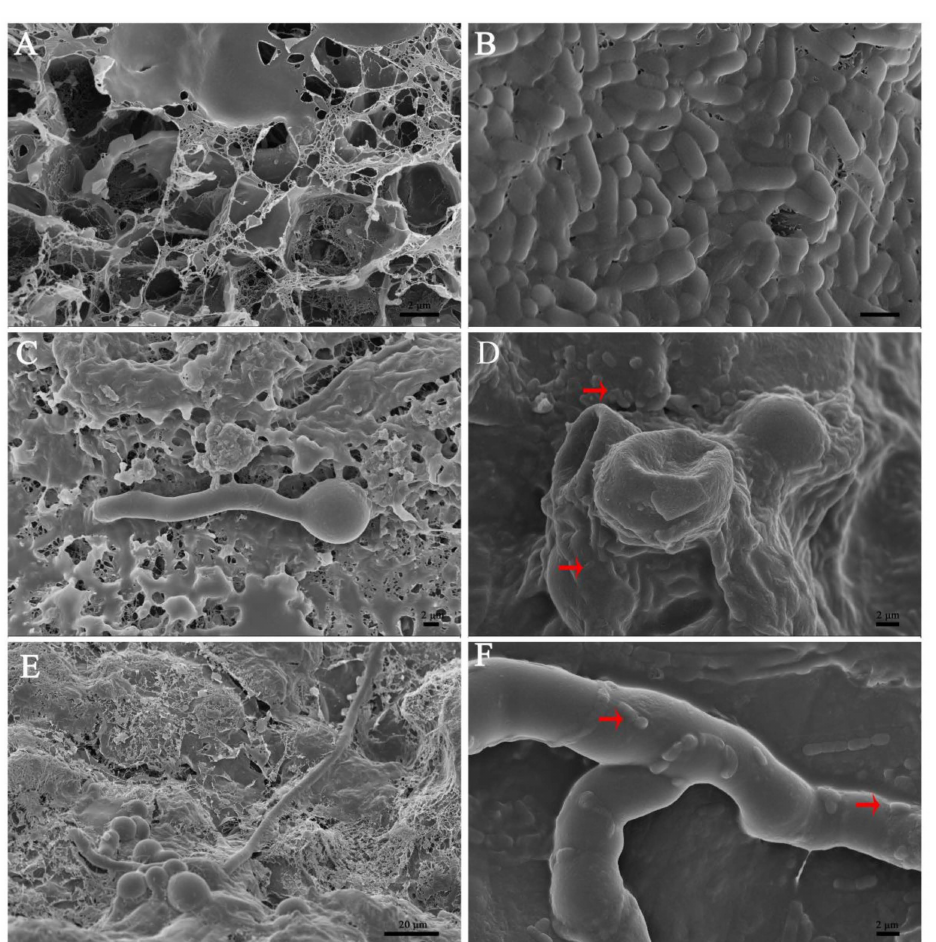
Figure 10. Scanning electron micrographs of colonization of endophyte Bacillus subtilis L1-21 on pathogens in citrus. Wound inoculation was carried out and the experiments were performed as ( A ) CK, 24h after treatment; ( B ) L1-21, 24 h after treatment; ( C ) Penicillium digitatum spore, 12 h after treatment, spores germinate normally; ( D ) P. digitatum spore + L1-21, 12 h after treatment, germinating spore deformity; ( E ) P. digitatum spores, 24 h after treatment; ( F ) P. digitatum spore + L1-21, 24 h after